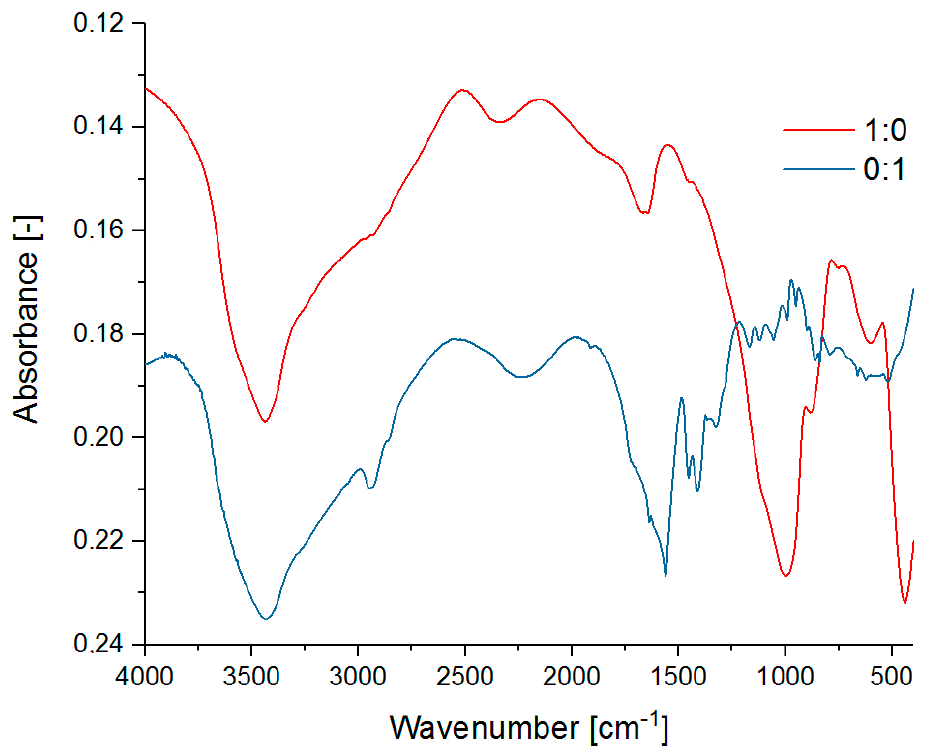
Figure 5. MIR spectra of the pure R-150 sodium water glass (1:0) and the cross-linked sodium polyacrylate (0:1).